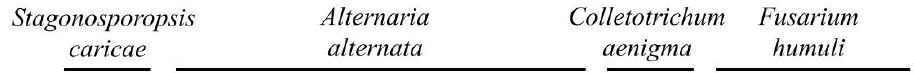
Figure 9. Anterior view of colonies of all fungal isolates on non-supplemented PDA and supplemented with 0.01, 0.1, 1, 10, or 100 µ g mL − 1 of fludioxonil.